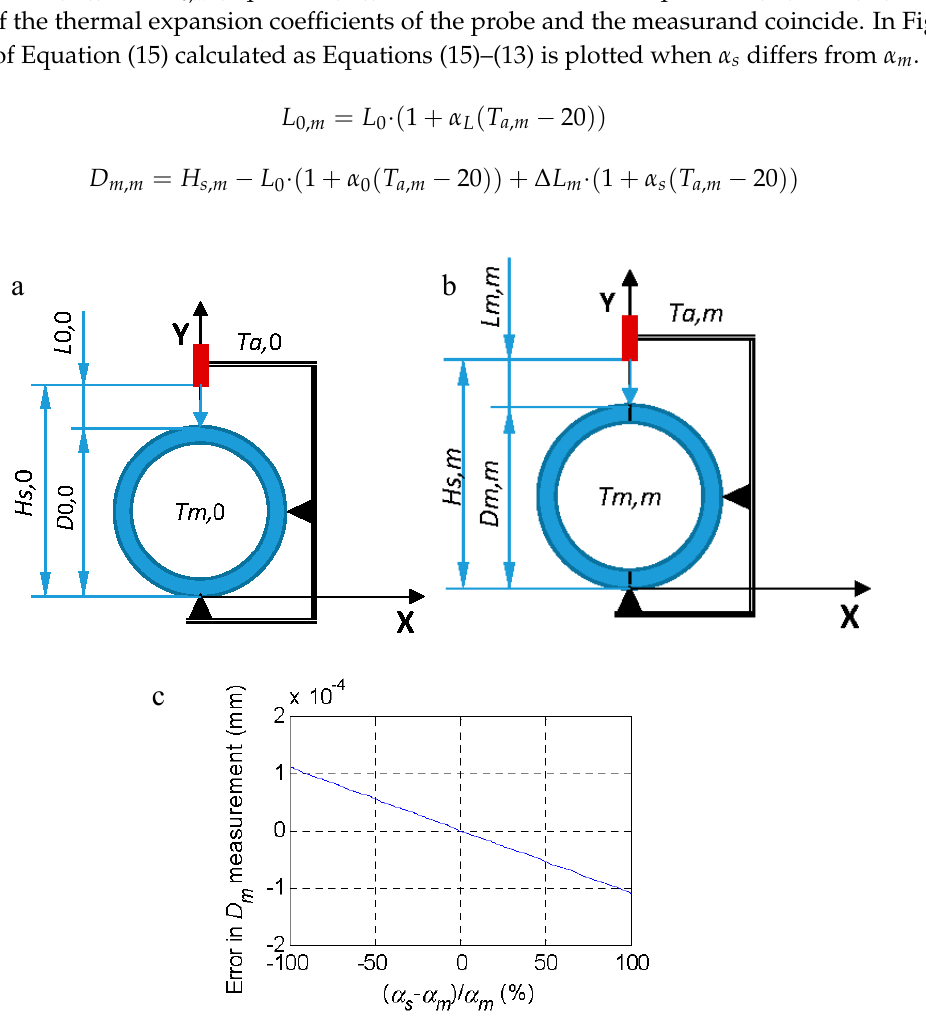
Figure 2. ( a ) Definition of the reference with D 0 at temperature T m, 0 = T a, 0 . ( b ) comparison with the part under inspection D m at temperature T m,m where the ambient temperature is T a,m . ( c ) Error (15)–(13) as a function of the difference between α s and α m for a temperature T m,m = 30 °C and T 0,0 = 20 °C.